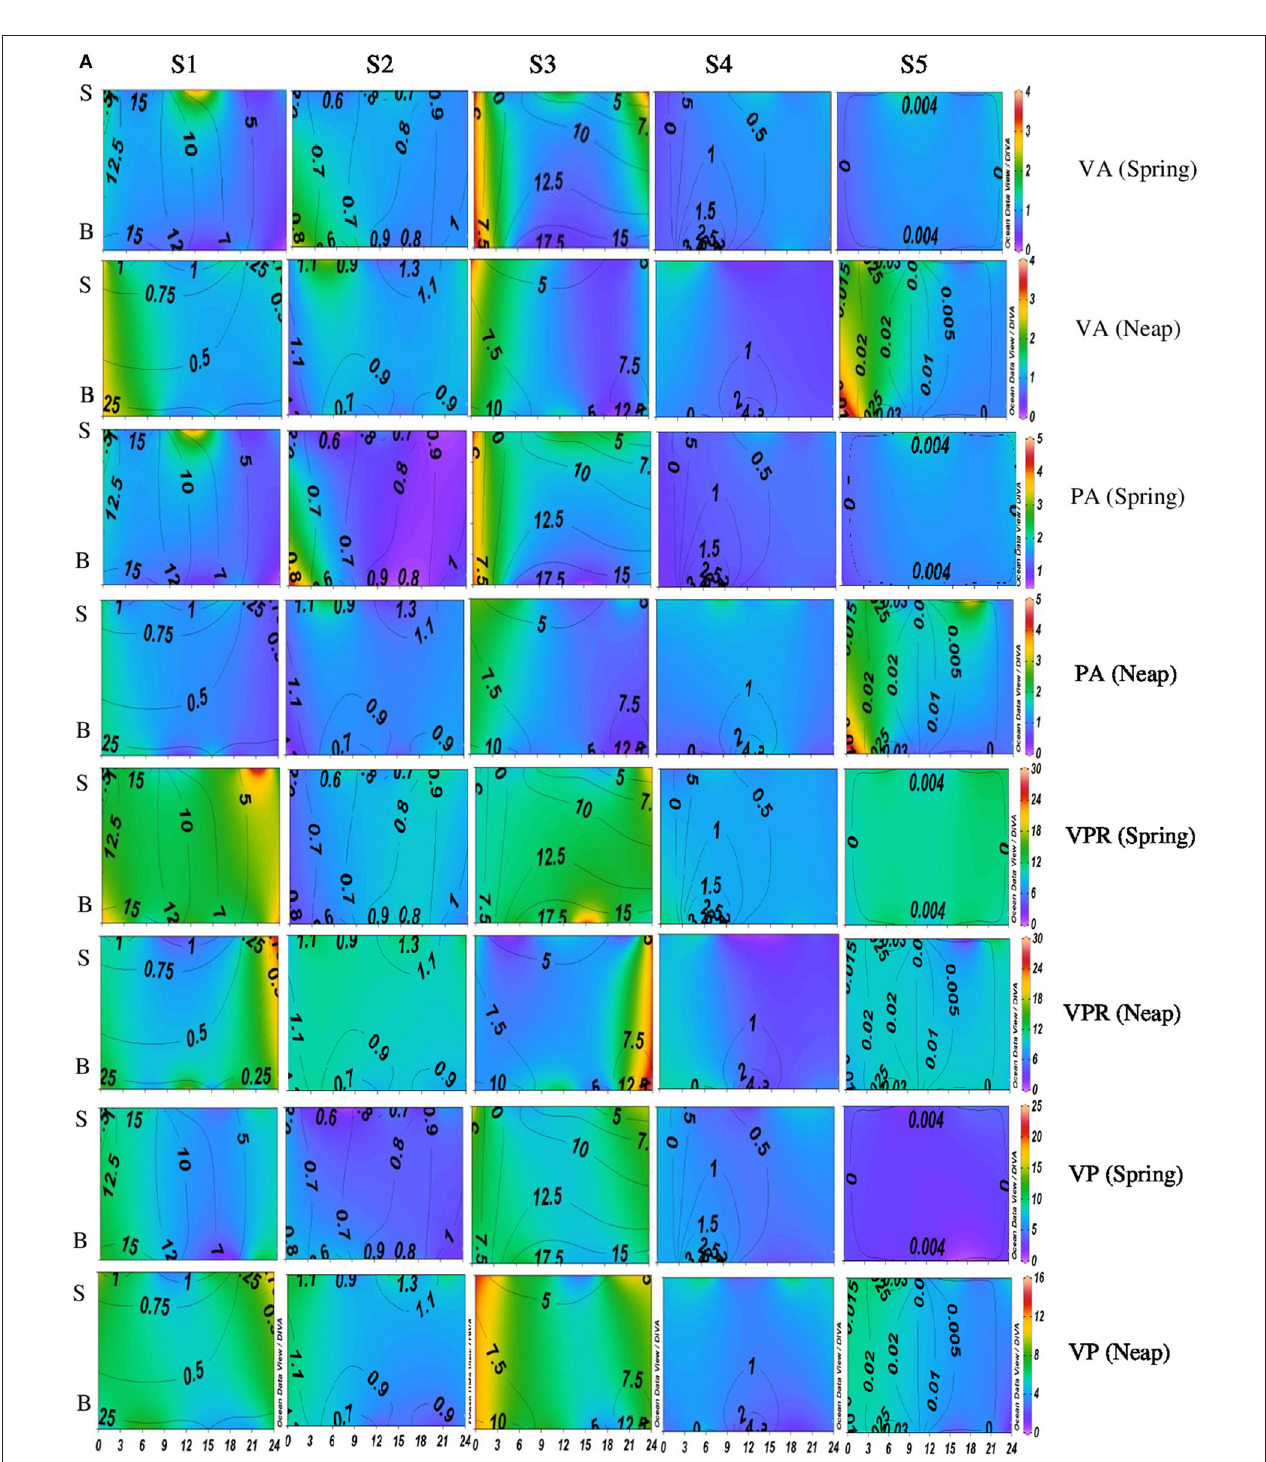
FIGURE 2A | Temporal variations (diel and tidal) in biological parameters during monsoon (MON) in CE. X- axis represents the time series observations from 00:00 to 24:00 h and Y-axis represent the vertical section of the water column (S, Surface; B, Bottom). Z-axis represent different parameters in color contours and salinity is superimposed as the line contours. The vertical panels S1, S2, S3, S4, and S5 represents the five stations. The horizontal panels represent various parameters during MON, such as viral abundance (VA) (10 6 VLPs mL − 1 ), prokaryotic abundance (PA) (10 6 Cells mL − 1 ), virus-to-prokaryote ratio (VPR), and viral production (VP) (10 10 VLPs L − 1 day − 1 ), during spring and neap phases separately.